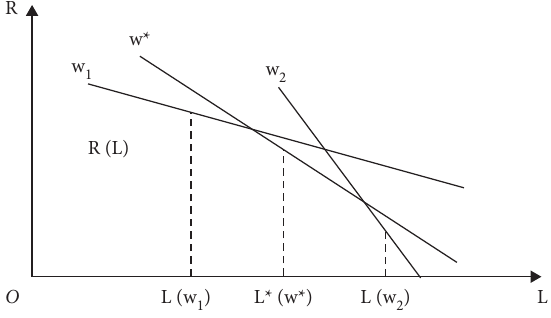
Figure 3: The curve of the public’s